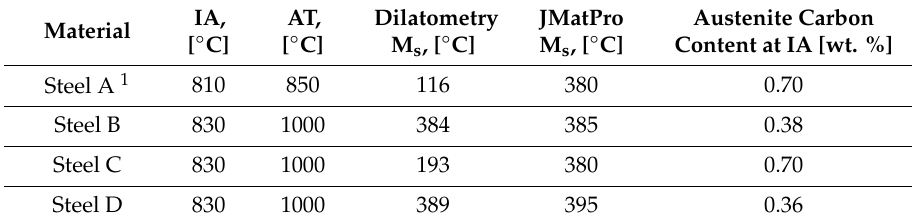
Experimentally determined and calculated M s temperatures. AT = dilatometry annealing